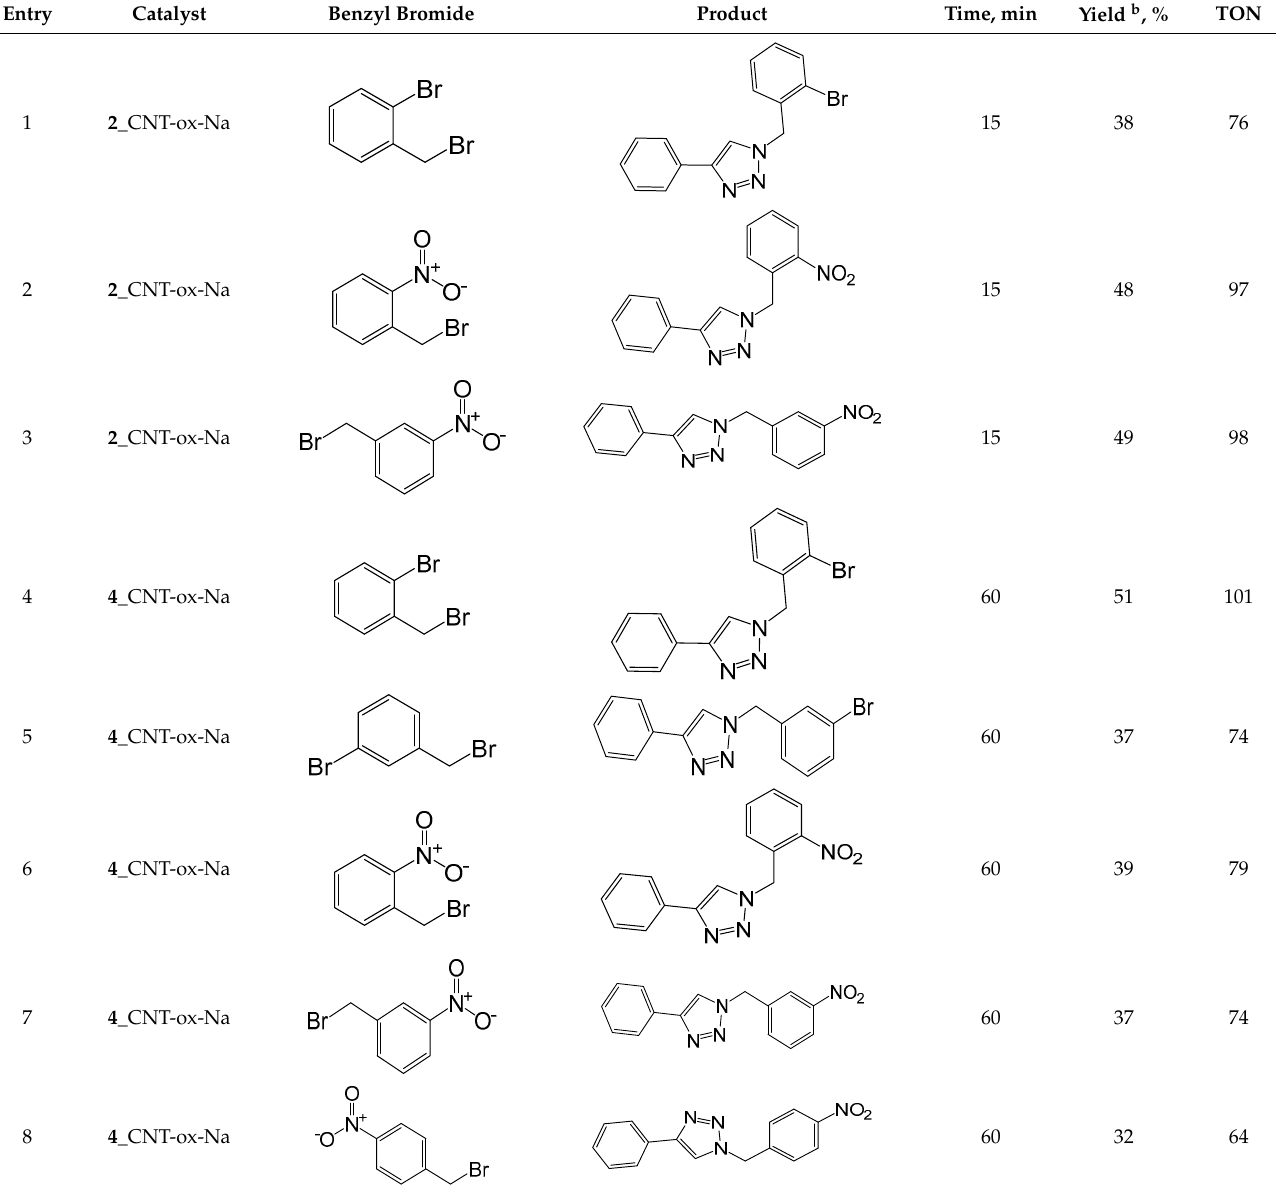
Table 4. Synthesis of triazoles using phenylacetylene and substituted benzyl bromides a . Entry Catalyst Benzyl